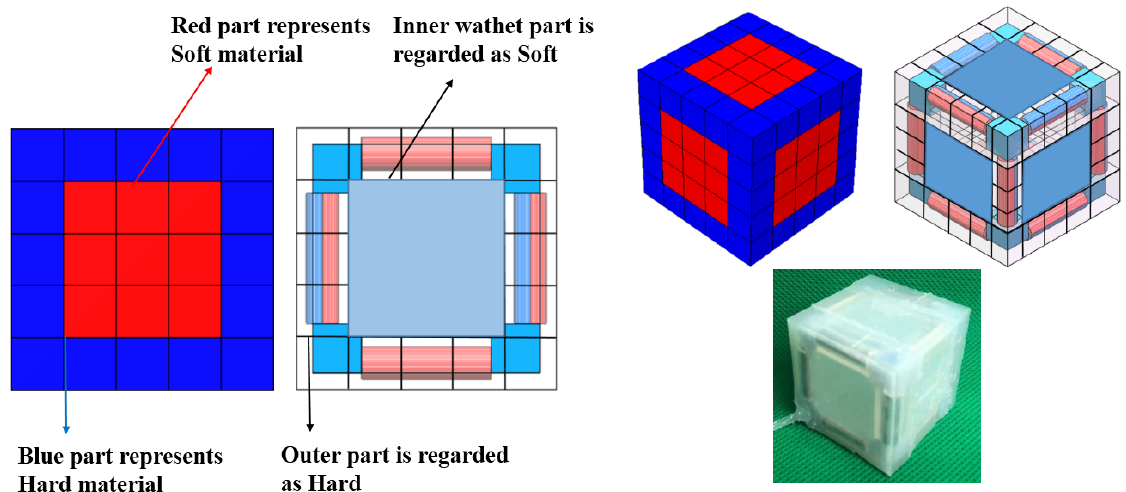
Figure 4. The geometrical relationship between the simulation model and real soft